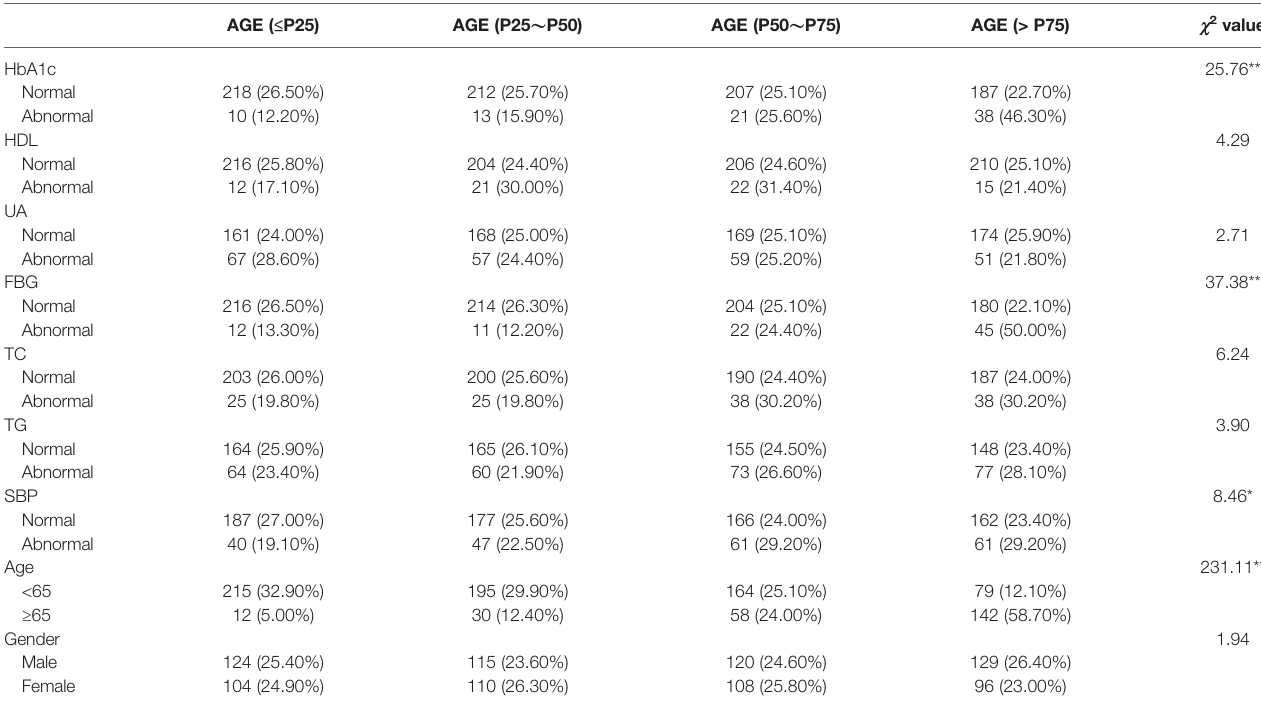
TABLE 1 | The prevalence characteristics of